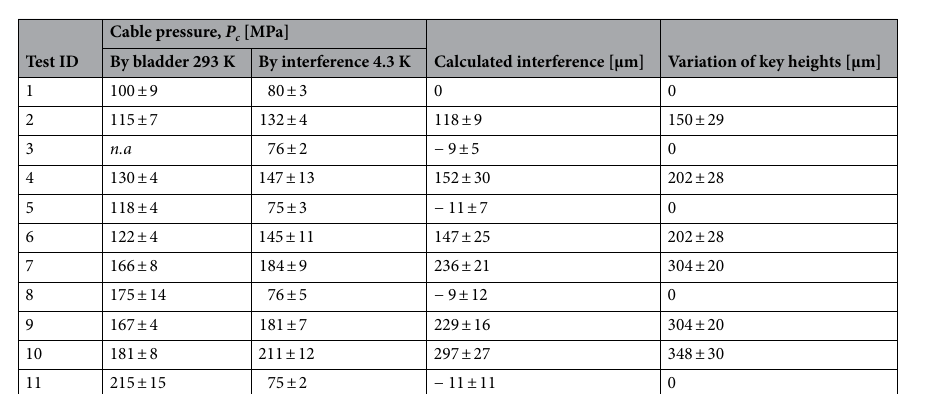
Table 2. Transversal pressure acting on the cable stack at RT and 4.3 K during the eleven different tests. The pressure is estimated in 6 different location by using the strain measured on the Al shell at RT temperature after a thermo-cycle. The interference is calculated with a 3D FEM model at room temperature, whereas the variation of the key heights is evaluated experimentally.